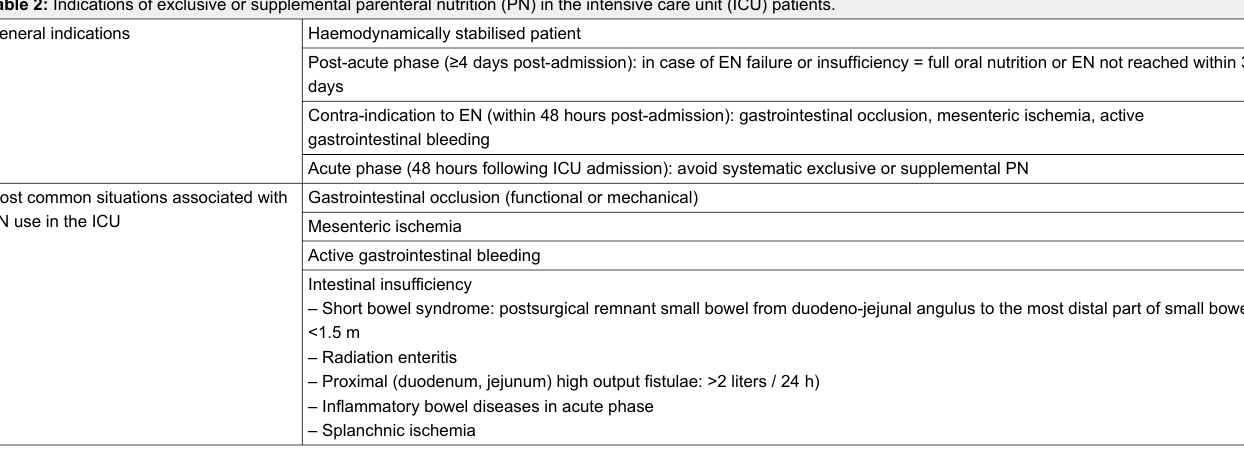
Table 2: Indications of exclusive or supplemental parenteral nutrition (PN) in the intensive care unit (ICU) patients. Haemodynamically stabilised